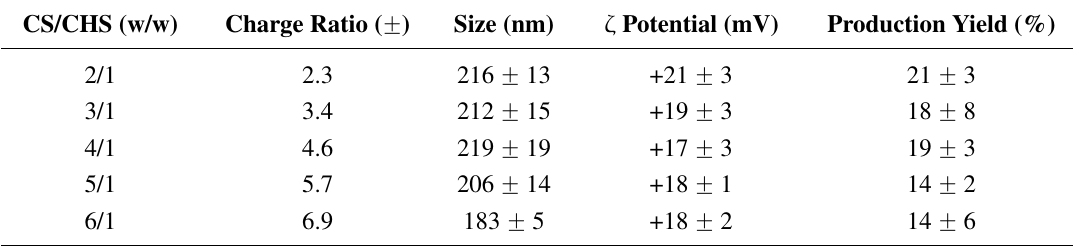
Table 1. Physicochemical characteristics and production yield of unloaded CS/CHS nanoparticles (mean ˘ SD, n ě 4).